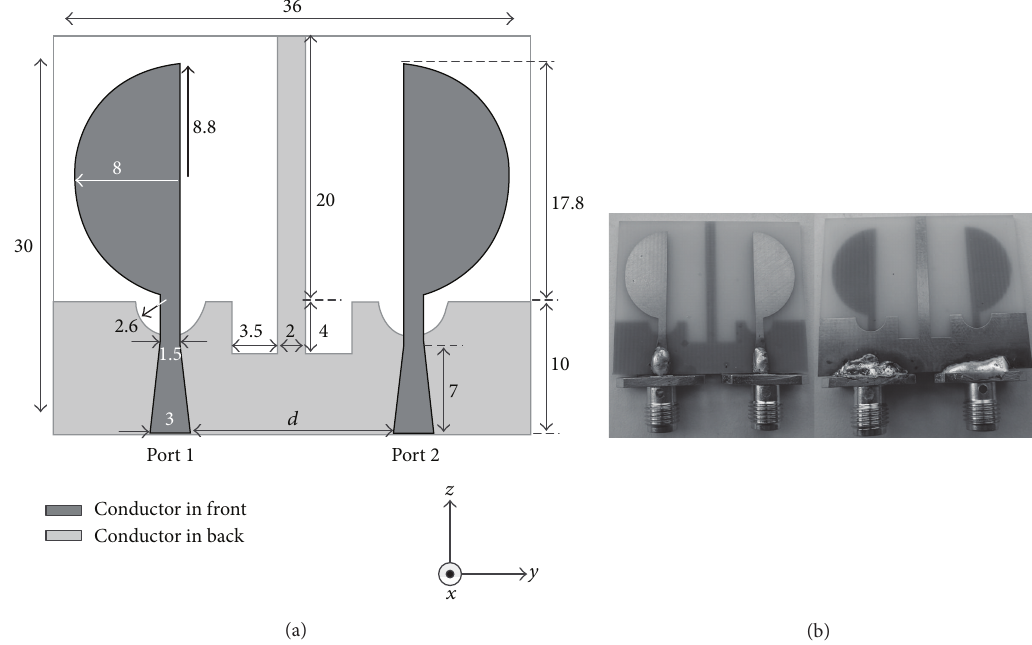
Figure 1: Geometry and photograph of the proposed antenna ( 𝑑 = 15.3 , dimensions,